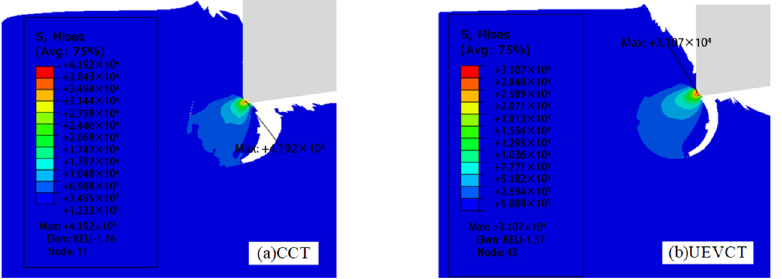
Figure 4. Comparison of maximum equivalent stress. ( a ) Maximum stress point during conventional cutting; ( b ) Maximum stress point during ultrasonic elliptical vibration cutting.